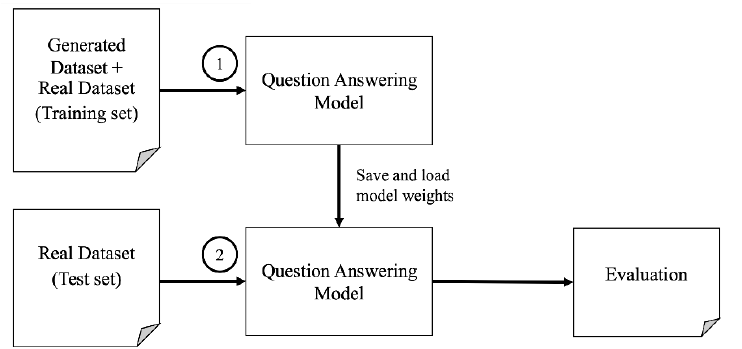
Figure 8. Illustration of the training flow of the Sequence Strategy.